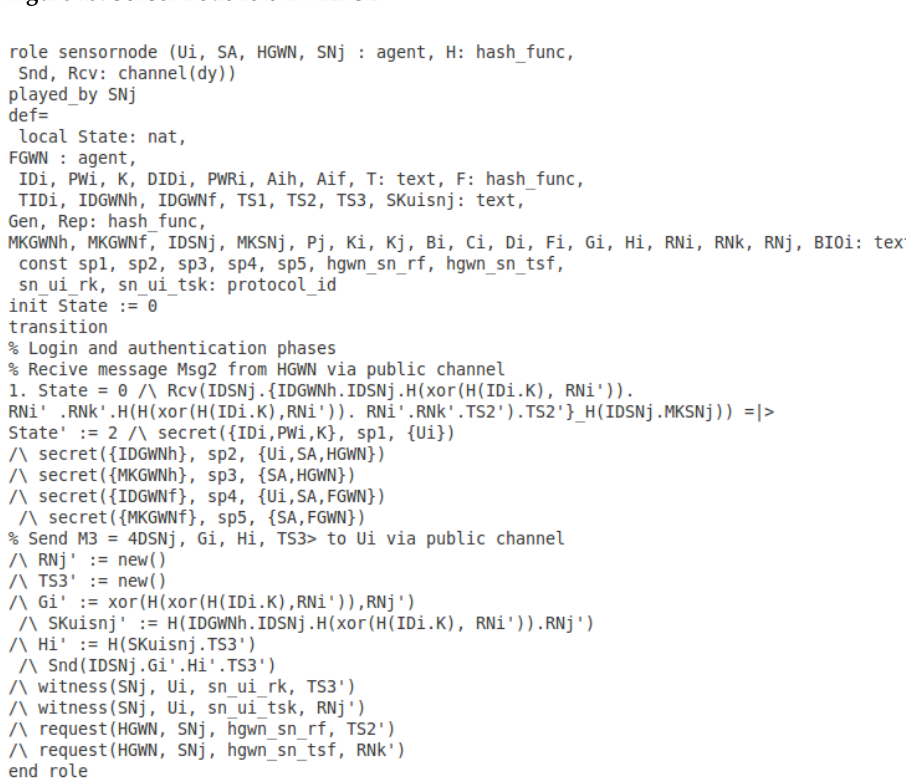
Figure 13. Sensor node role in HLPSL.